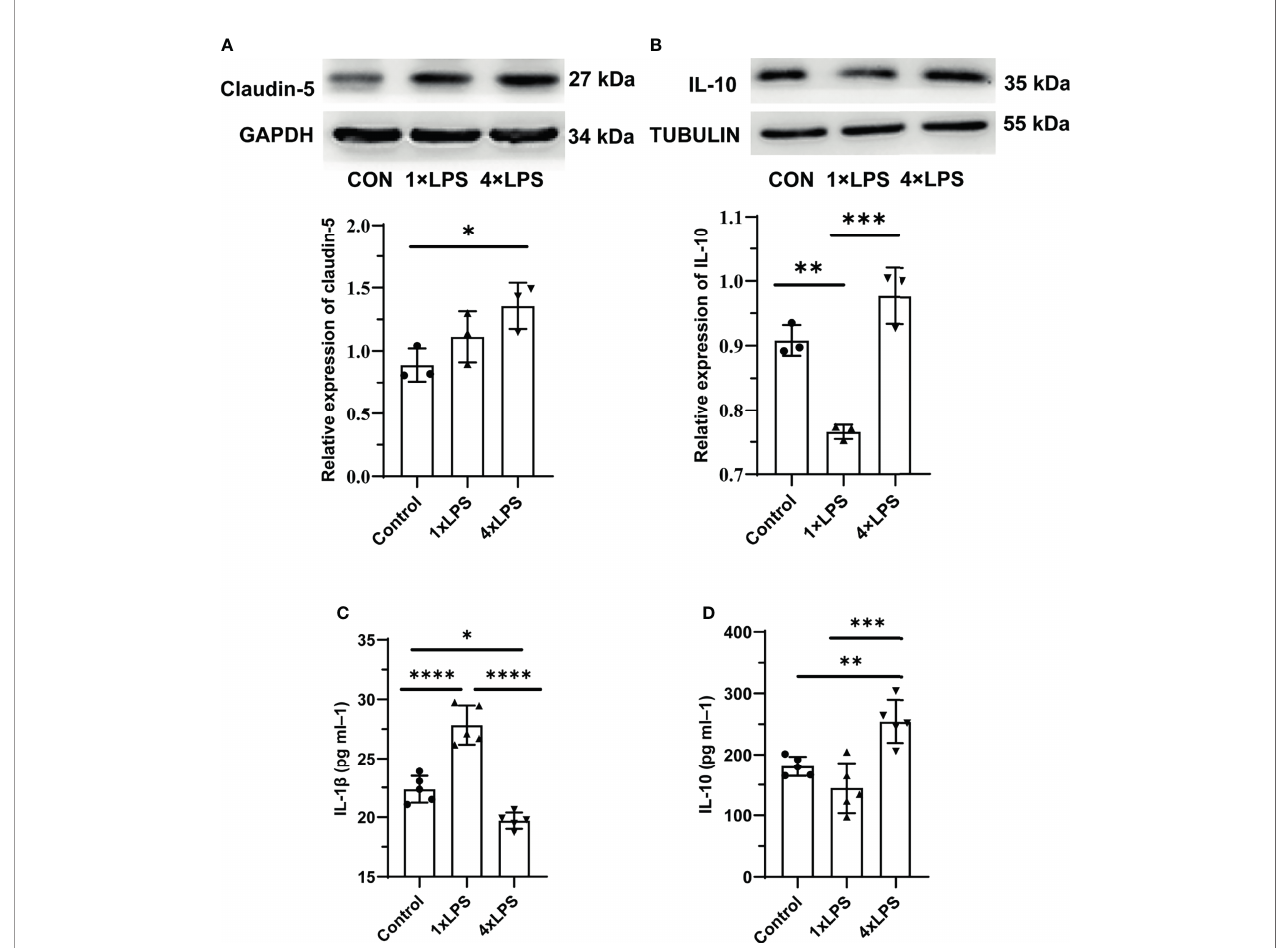
FIGURE 4 | Intestinal barrier and systemic in fl ammation after establishing epilepsy model. (A) Western blot showing protein expression of Claudin-5 protein. Data are expressed as the mean ± SEM (n = 3 per group). (B) Western blot showing protein expression of IL-10 protein. Data are expressed as the mean ± SEM (n = 3 per group). (C) Serum IL-1 b level in 24h after epilepsy induced by kainic acid (n = 5 per group). (D) Serum IL-10 level in 24h after epilepsy induced by kainic acid (n = 5 per group). *P < 0.05; **p < 0.01; ***p < 0.001; ****p < 0.0001 by one-way ANOVA (and nonparametric or mixed) followed by methods of multiple comparisons. GAPDH: Glyceraldehyde 3-phosphate